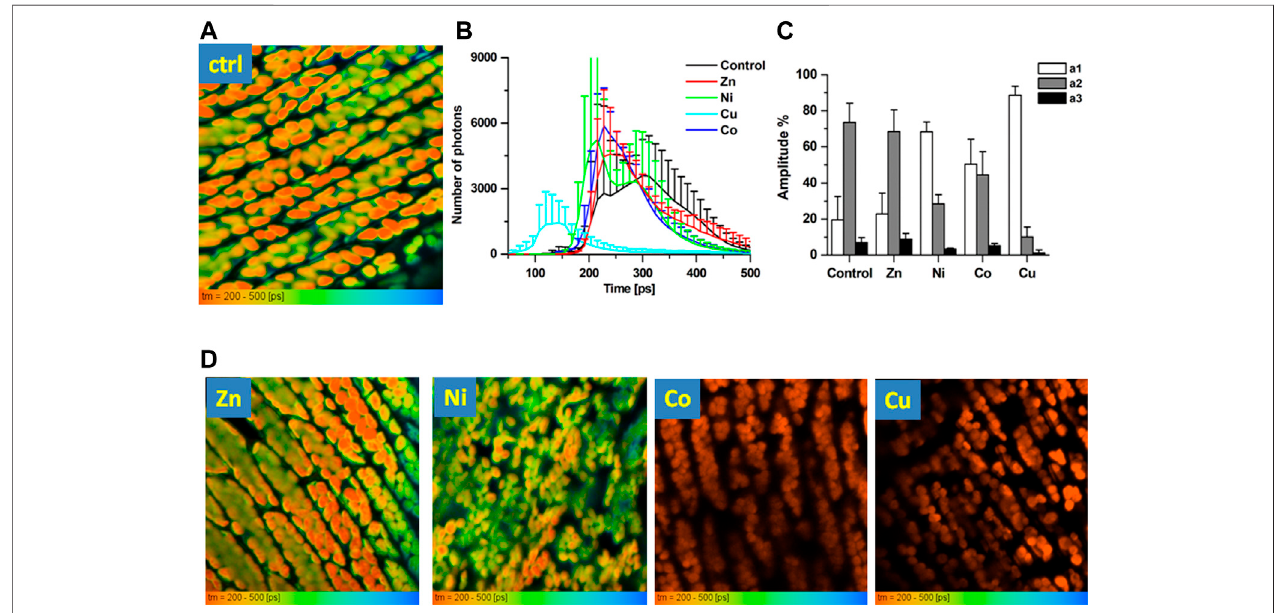
FIGURE 4 | FLIM images of Fontinalis antipyretica moss. (A) An original FLIM image in control conditions (CTRL) following excitation at 475 nm, using LP 500 nm emission fi lter. Lifetime distribution showed in the range 200 – 500 ps; (B) histograms of fl uorescence lifetimes in the recorded conditions illustrated between 50 and 500 ps. (C) Amplitudes gathered by a3-exponential decay for fi xed lifetimes of 100 ps (a1, component 1) and 350 ps (a2, component 2), with residual third component a3 ( n (cid:2) 6 in Ctrl, n (cid:2) 5 in Zn, n (cid:2) 7 in Ni, n (cid:2) 6 in Co, n (cid:2) 4 in Cu). (D) Representative FLIM images in the presence of Zn, Ni, Co and Cu NPs, scale 200 – 500 ps.